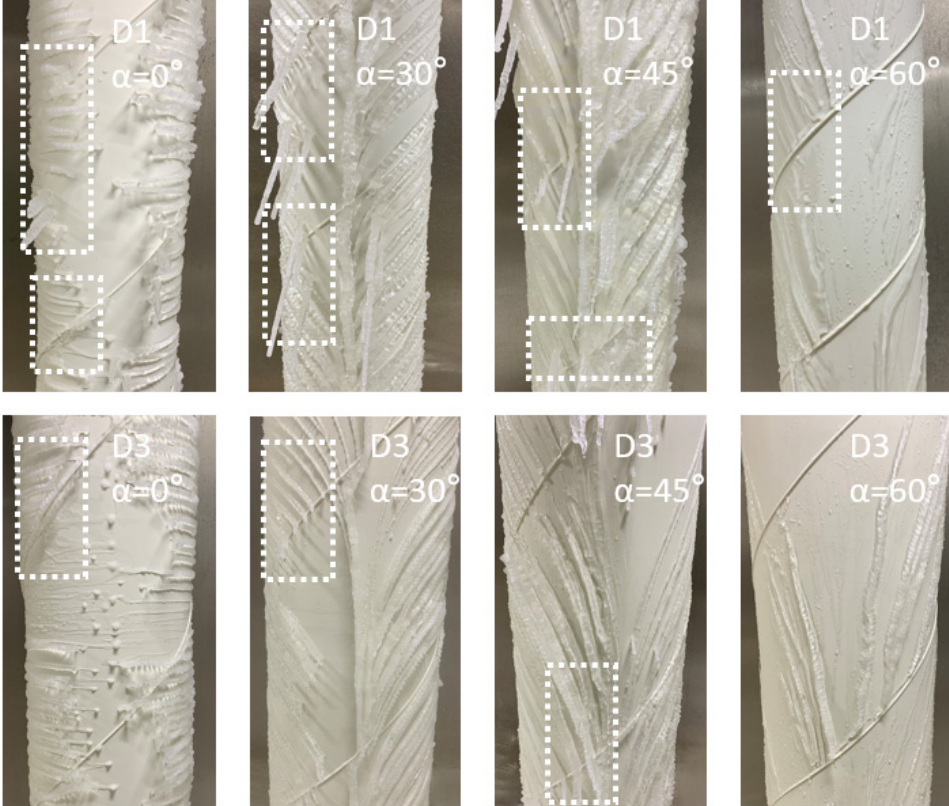
Figure 5. − 25°, Icing conditions of the bo tt om surface under di ff erent diameters and inclination an- Figure 5. − 25 ◦ , Icing conditions of the bottom surface under different diameters and inclination angles. gles.